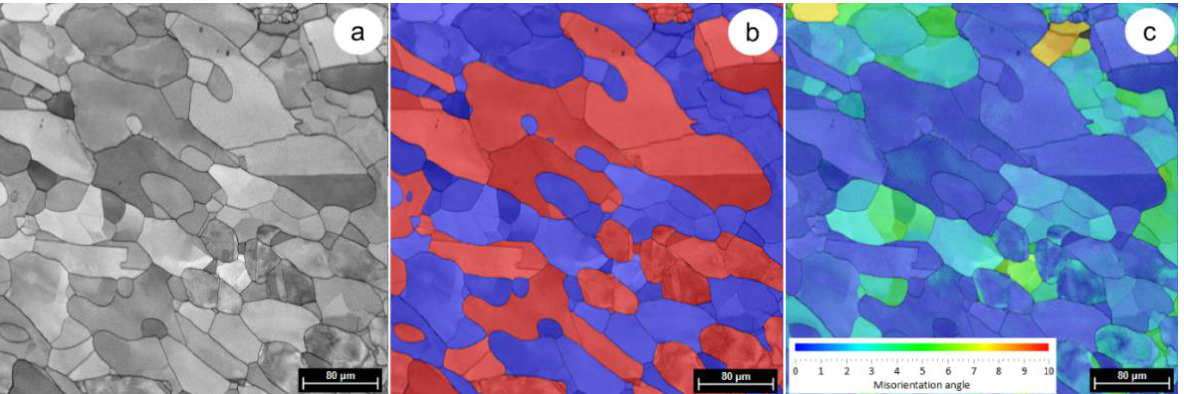
Figure 3. Typical SEM-EBSD microstructure images of AR UNS S32750 Super-Duplex Stainless Steel ( a ); distribution map of constituent phases (γ-phase—red colorized and δ-phase—blue colorized) ( b ); GROD distribution map for both γ-phase and δ-phase ( c ).